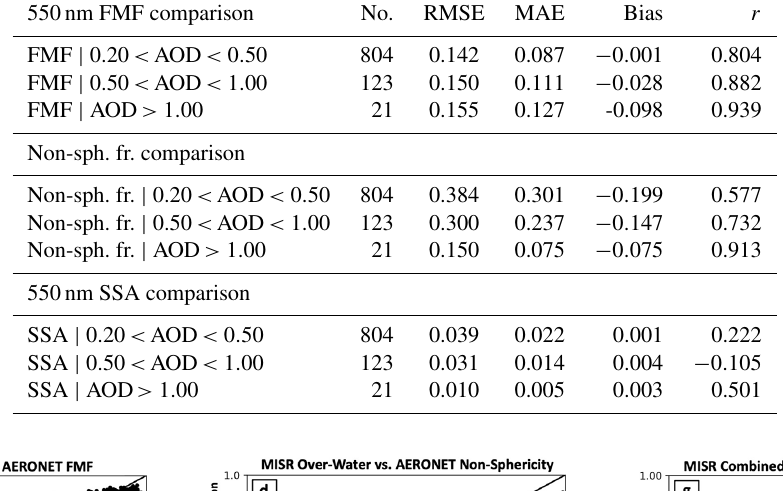
Table 6. MISR RA vs. AERONET almucantar inversion statistics over water. Same as Table 4, except for MISR RA vs. AERONET inversion statistics over water. All MISR data correspond to the combined surface algorithm. Note that AERONET inversion results are not ground truth; they represent retrieval results. The AERONET team cautions against the use of results when blue-band AOD < 0 . 4, so comparisons for green-band AOD < 0 . 50 should be considered qualitative rather than quantitative.